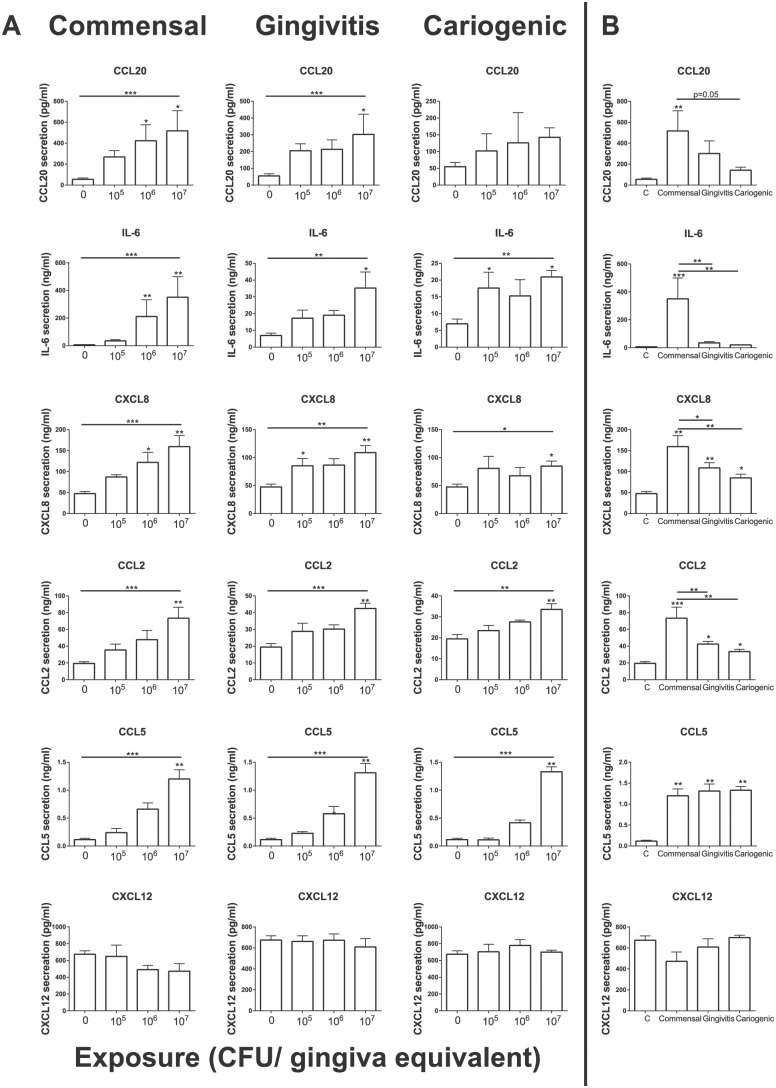
Cytokine secretion by gingiva equivalents after exposure to different
biofilms. (A) Cytokine secretion (CCL20, IL-6, CXCL8, CCL2,
CCL5, CXCL12) of gingiva equivalents after exposure to 0,
105, 106, or 107 colony-forming units
(CFU) of the commensal, gingivitis, or cariogenic biofilms. The 3
biofilms show a dose-response for IL-6, CXCL8, CCL2, and CCL5. The
secretion of CCL20 was increased after exposure to commensal and
gingivitis biofilms but not cariogenic biofilms. CXCL12 secretion was
not affected. (B) The cytokine secretion by the gingiva
equivalents after exposure to 0 (control) or 107
colony-forming units of the different biofilms was compared. CCL20,
IL-6, CXCL8, and CCL2 secretion was lower after exposure to the
pathogenic biofilms than after exposure to the commensal biofilm. Data
represent the mean ± SEM of 3 individual experiments in duplicate as
compared by Kruskal-Wallis test (horizontal lines) and Dunn’s
multiple-comparison test (stars above columns vs. control).
*P < 0.05. **P < 0.01.
***P < 0.001.